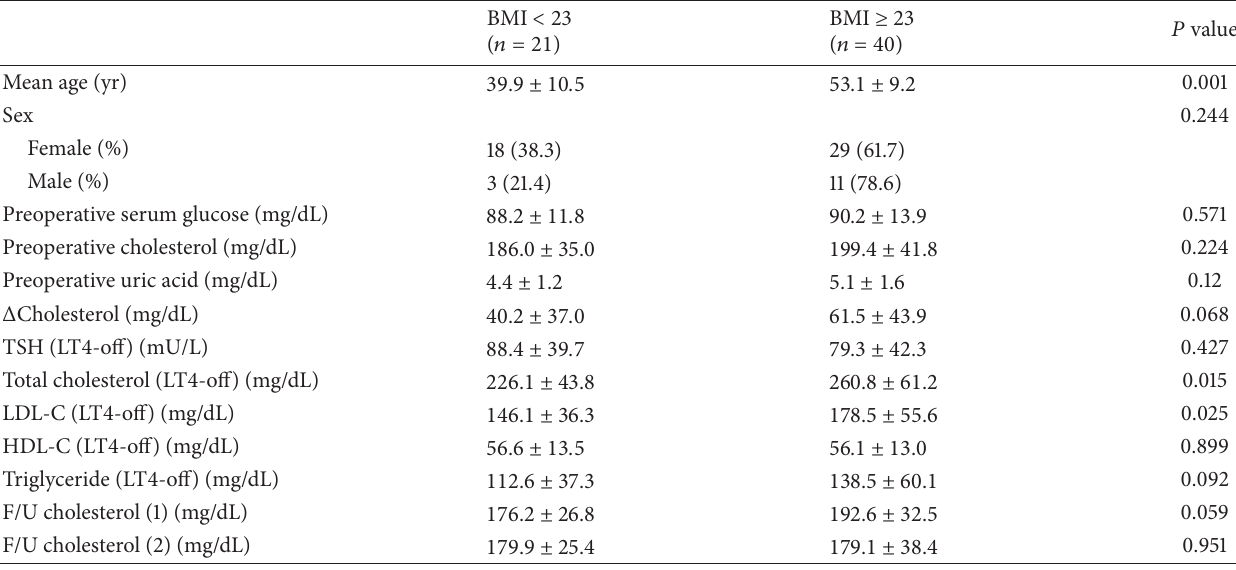
Table 4: Different serial change of lipid profile according to BMI of 23 kg/m 2 .